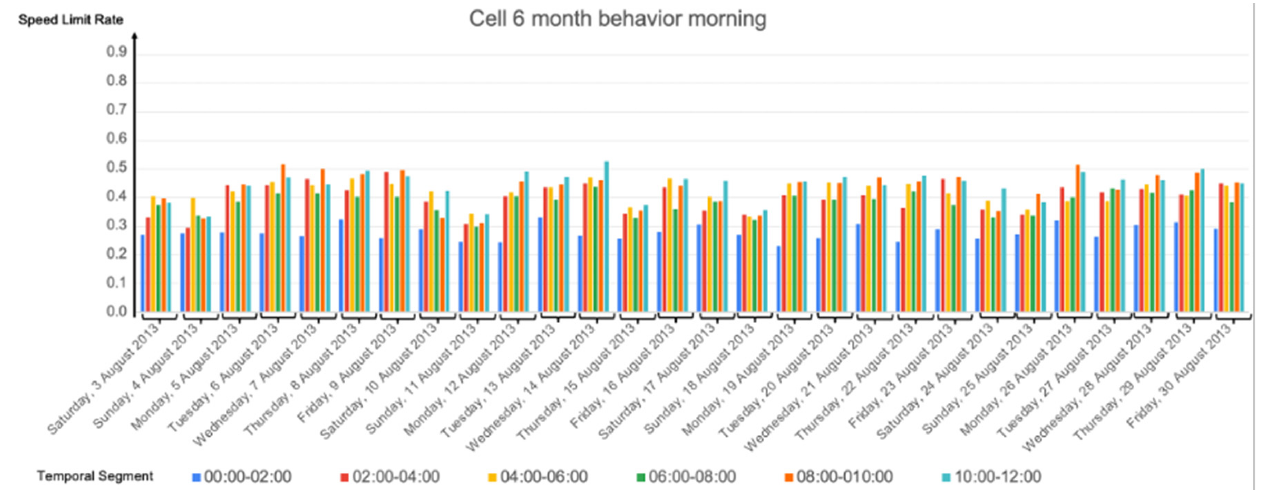
Figure 10. Calculated speed limit rates for the 28 days, cell 6 with MaxSpeed = 50 km/h in the morning.